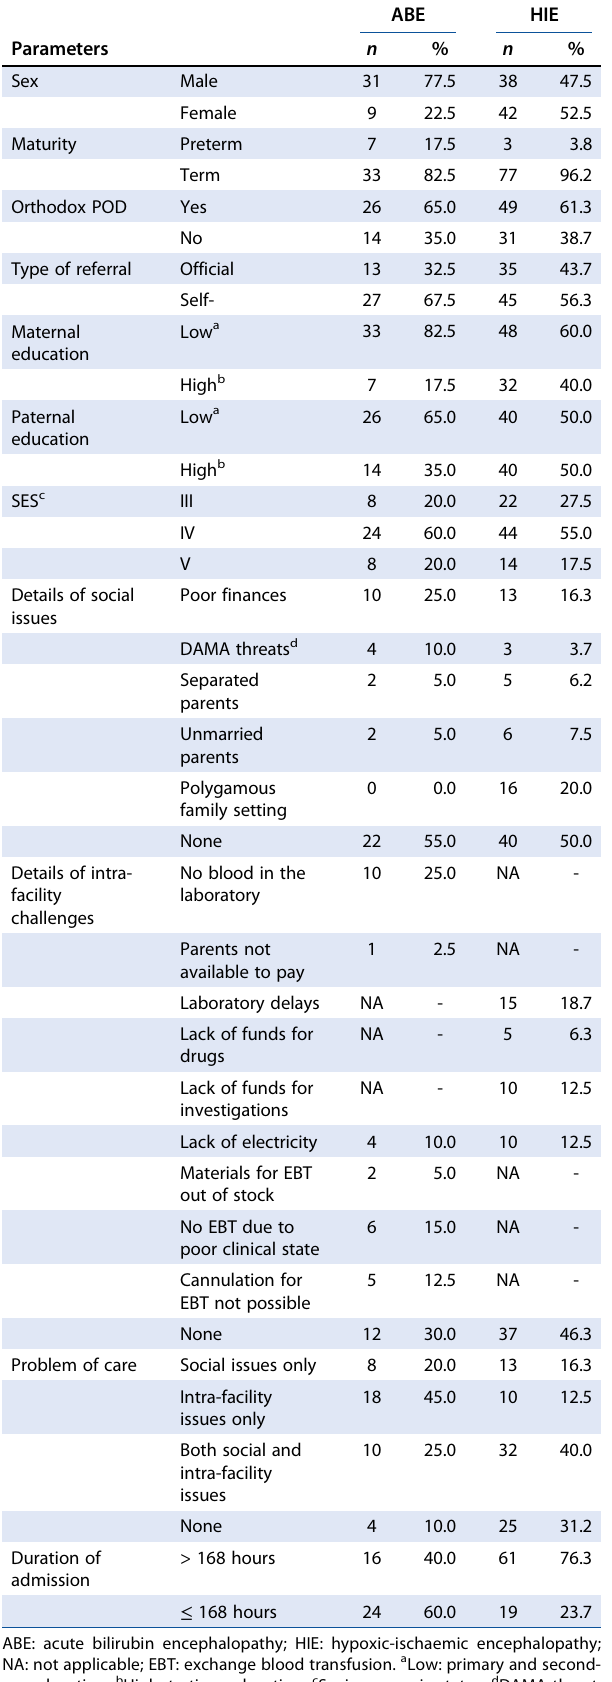
Table 1: Characteristics of the babies with acute bilirubin and hypoxic-ischaemic encephalopathies